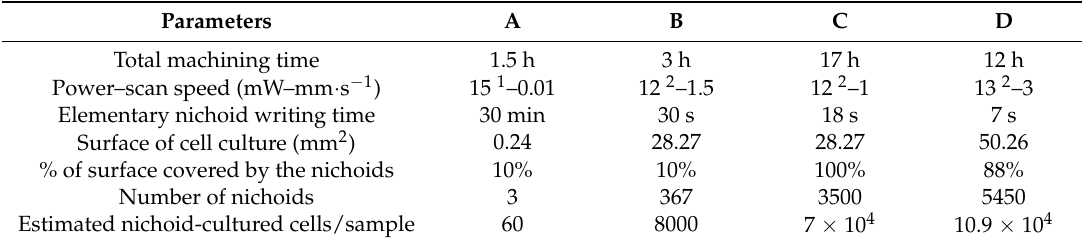
Table 1. Technical parameters regarding the various nichoid layouts and upscaling processes. A = three elementary nichoids, B = 367 elementary nichoids, C = continuously-packed nichoids (CPN), D = fractionated supermatrix of nichoids (FSN).